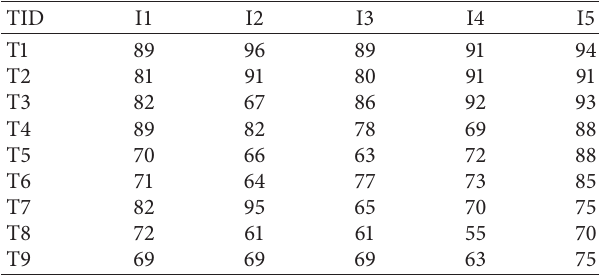
Table 1: Transaction database with 1-itemsets.